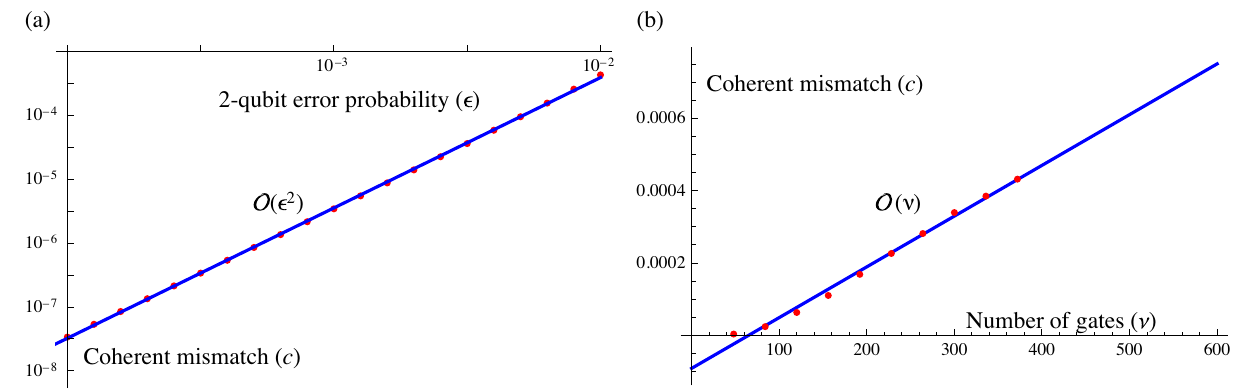
ffiffiffiffiffiffiffiffiffiffiffi ffiffiffi p p 1 − c c j ψ i þ j ψ err i of the density matrix ρ in case of a purely incoherent